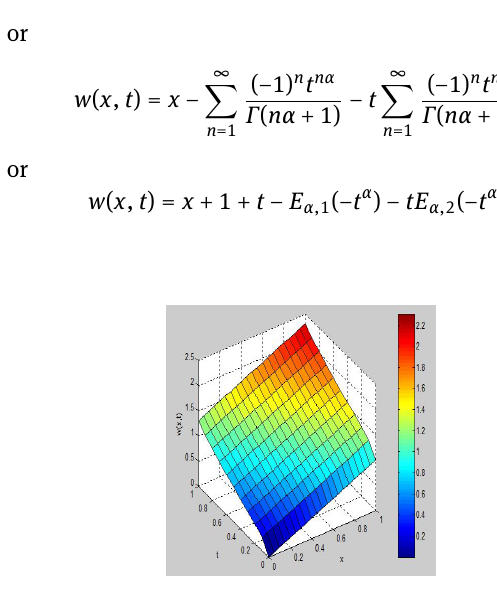
Fig. 11: Surface graph of w ( x , t ) of eq. (8.7), when α = 0.6